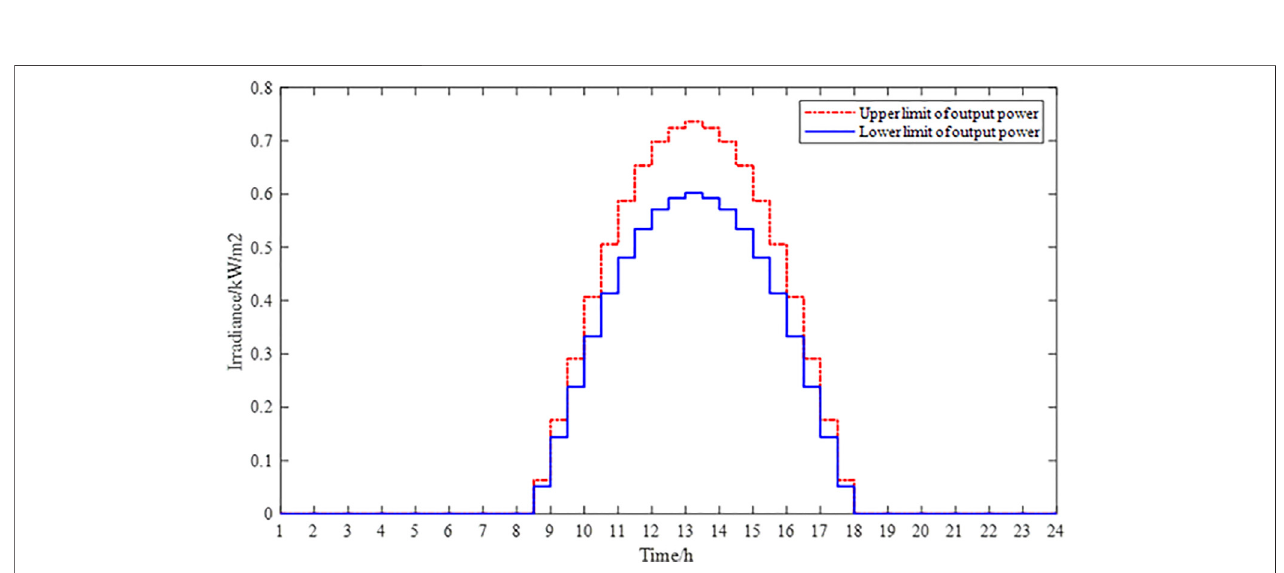
FIGURE 7 | Light irradiance prediction